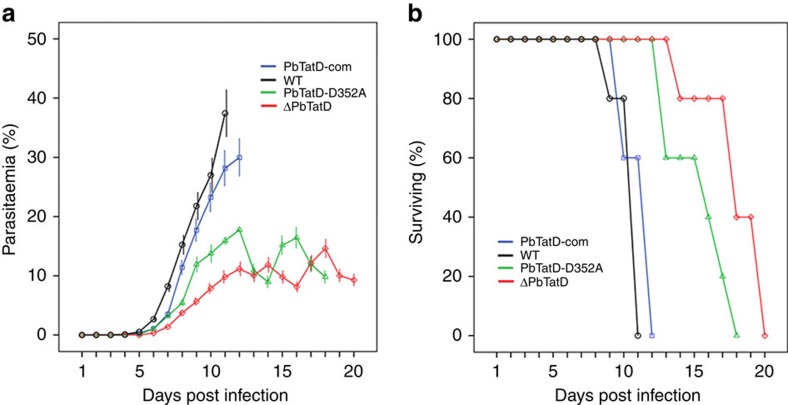
A comparison of the parasitaemia and survival of mice infected with WT and mutated strains.(a) A comparison of the mean parasitaemia with standard variations of the mice that were infected with WT P. berghei, ΔPbTatD, PbTatD-D352A and PbTatD-com parasites from day 1–20 after infection. The parasitaemia in mice that were infected with either ΔPbTatD (red line) or PbTatD-D352A (green line) was lower than in mice infected with WT (black line) or PbTatD-com parasites (blue line). The error bars indicate s.d. (b) The curves representing the survival rates of the mice that were infected with WT, ΔPbTatD, PbTatD-D352A and PbTatD-com strains. The mice that were infected with the WT exhibited 100% death 11 days after IP injection with 106 infected RBCs. The PbTatD-com strain exhibited a similar result as WT, whereas the mice that were infected with the ΔPbTatD and PbTatD-D352A strains exhibited a twofold longer survival time.